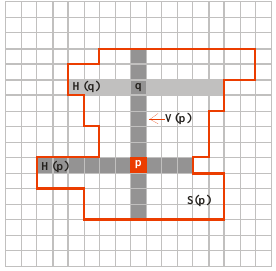
Figure 2. Expansion of the cross-based support region S( p ) dri- ven by the skeleton of each pixel. The skeleton pixels for V( p ) and H( p ) sets are calculated only once per pixel. When pixel q belongs to V( p ), the corresponding horizontal arm H( q ) is add- ed to S( p ). S( p ) consists of the union of H( q ) for all pixels q which participate in V( p ). [After Zhang et al., 2009.]